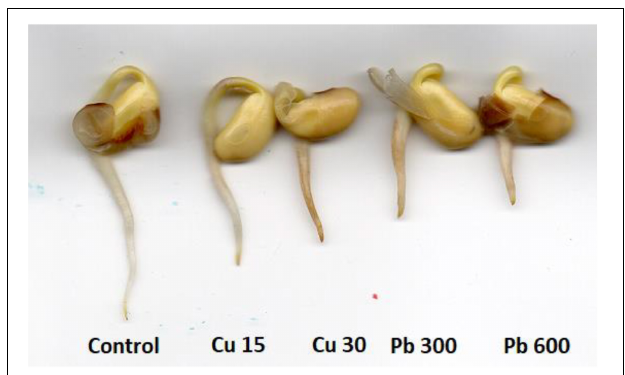
FIGURE 2 | The morphology of control soybean seedlings and soybean seedlings subjected for 24 h to CuSO 4 solution with Cu at concentration 15 and 30 mg/l (Cu 15 and Cu 30, respectively) and Pb solution with PbCl 2 at the concentration 300 and 600 mg/l (Pb 300 and Pb 600,